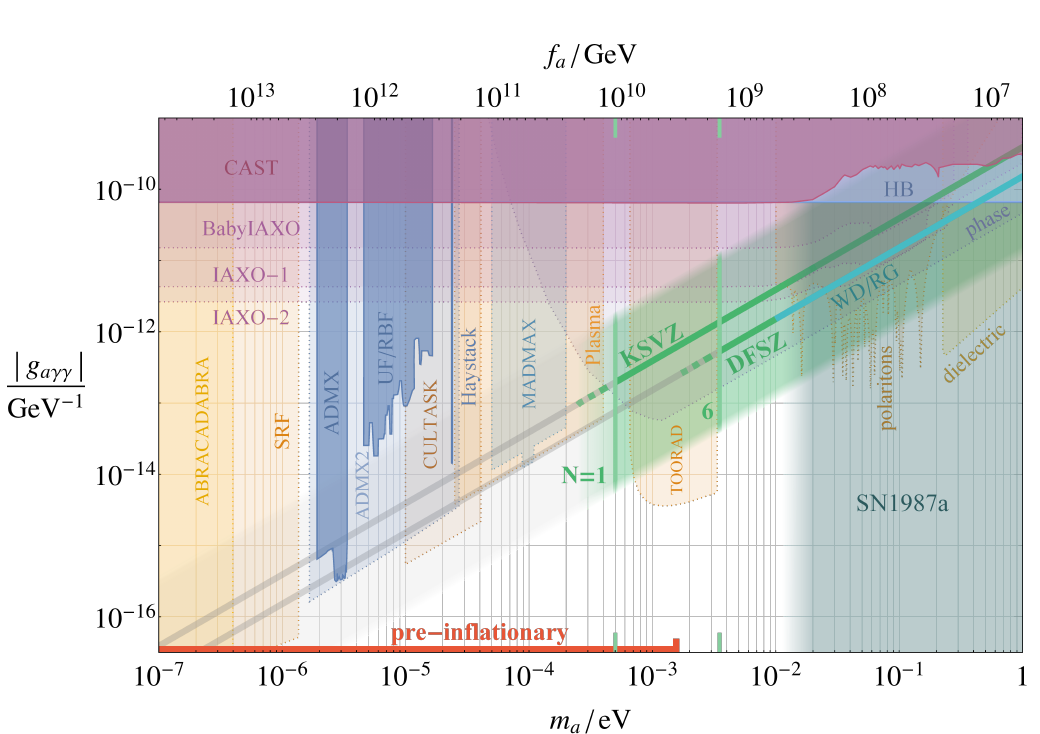
Figure 5: The axion parameter space in terms of its mass and coupling to photons g . Solid green lines indicate the allowed parameter space in the post-inflationary a γγ scenario for the minimal KSVZ model and the DFSZ model, given our constraints from dark matter overproduction (eqs. (6) and (7)), while the dashed green lines indicate our estimate of the uncertainty on these results. The green shaded band indicates the post-inflationary parameter space allowed by the bound for more gen- eral axion models. Vertical green lines show our lower bounds on the axion mass = 0.5 meV and m = 3.5 meV for N = 1 and N = 6 respectively. We also at m a a indicate, in red, the allowed axion masses in the pre-inflationary scenario (the cor- responding g lie in the partially transparent grey band), the upper limit of which a γγ (cid:174) 1.5 · 10 − 3 eV is set by isocurvature fluctuations. Existing experimental bounds m a and observational constraints (solid lines) on g as a function of the axion mass a γγ and the projected sensitivity of proposed experiments (dotted) are also shown. The limit on DFSZ models from white dwarfs and red giants (“WD / RG”) is indicated for tan β = 1 [ 75 ] , while the supernova-1987a limit on such models (“SN1987a”) spans the blurred region as tan β varies (the corresponding constraint on KSVZ models is < 15 meV) [ 70 ] . The post-inflationary region that we identify could also be m a probed by future experiments sensitive to the axion’s couplings to matter [ 54,59 ] . In combination with the bound from supernova, the region of viable QCD axion masses ≈ 0.5 ÷ 20 in the post-inflationary scenario is restricted to m a